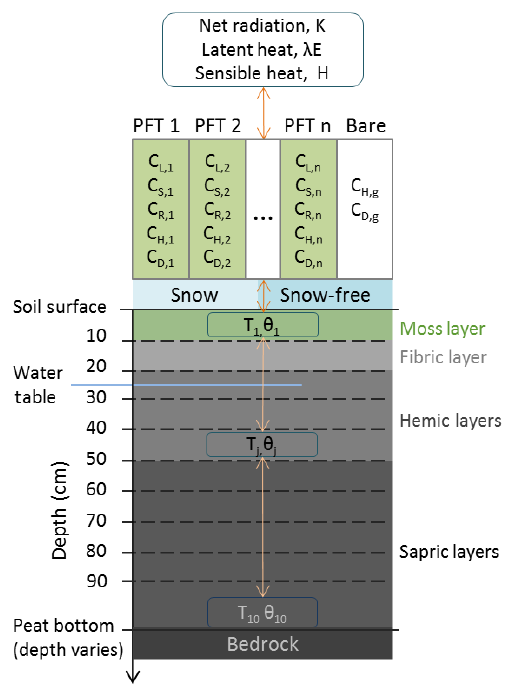
Figure 1. Schematic diagram of the peatland CLASS–CTEM model with 12 PFTs and 10 soil layers. The symbols C, T , and θ represent carbon, temperature, and soil water content respectively. The sub- scripts L, S, R, H, and D represent leaf, stem, root, fresh litter, and old litter